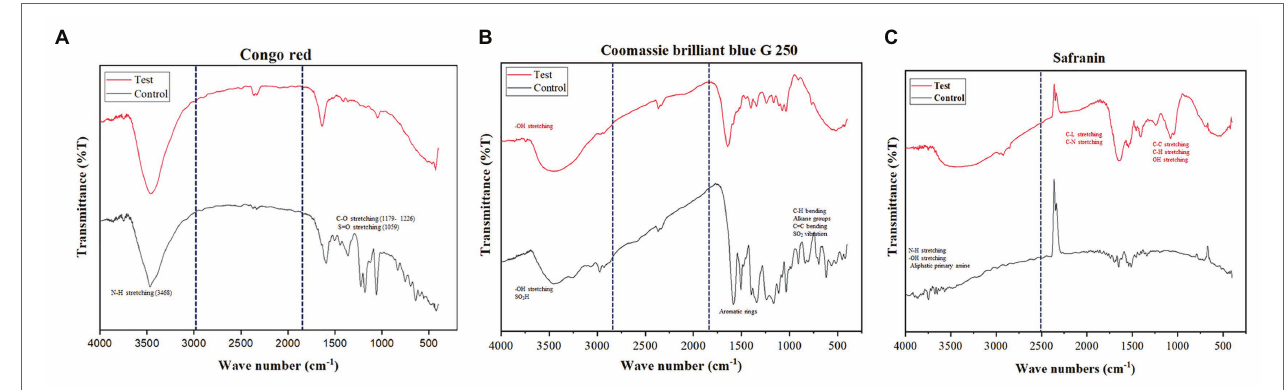
FIGURE 5 | Functional group analysis of all dyes before and after decolorization. Control indicates dye before decolorization and test indicates dye after decolorization. The important functional groups, aromatic rings, and aliphatic groups are highlighted in the control and in the test. Where, (A) is Congo red, (B) is CBB G 250, and (C) is